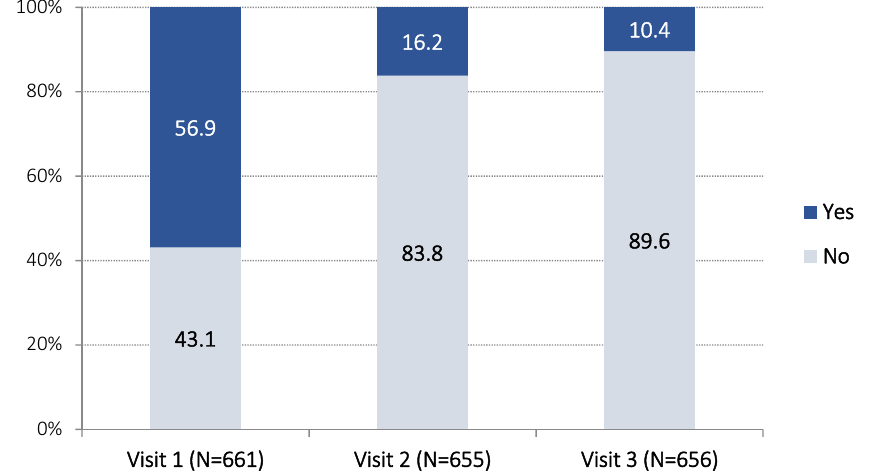
Figure 4. Percentage of patients using short-acting beta-2 agonists (yes-no), during the last month before each visit.